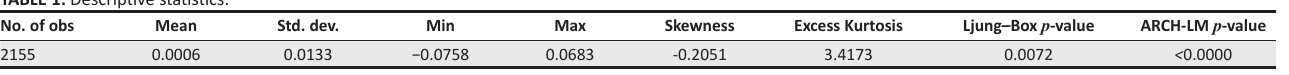
FIGURE 1: Time series plot of (a) daily JSE All Share Index and (b) daily JSE All Share Index log returns from 20 May 2005 to 31 December 2013 (in-sample data set). TABLE 1: Descriptive